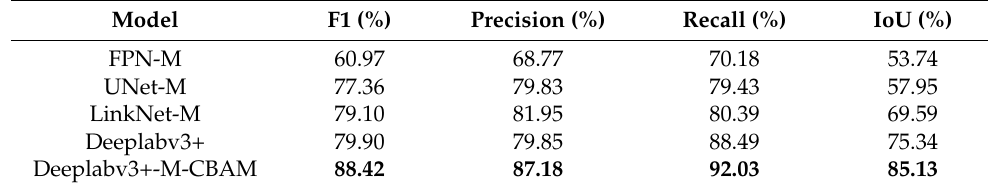
Table 5. Comparisons for BSL extraction accuracies for different models on BSL test set.